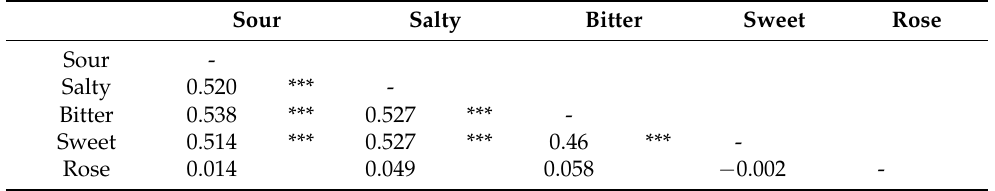
Table 2. Spearman correlations between z-transformed taste thresholds for sweet, salty, sour, and bitter. Sour